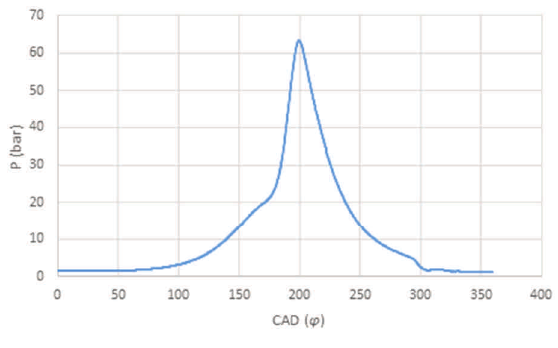
Fig. 4a. Graph of cylinder pressure against